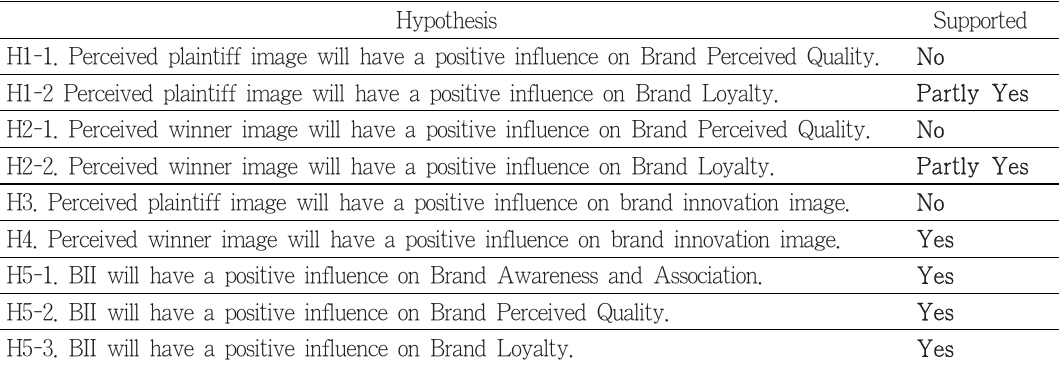
<Table 5> Summary of Hypothesis Findings of Structural Equation